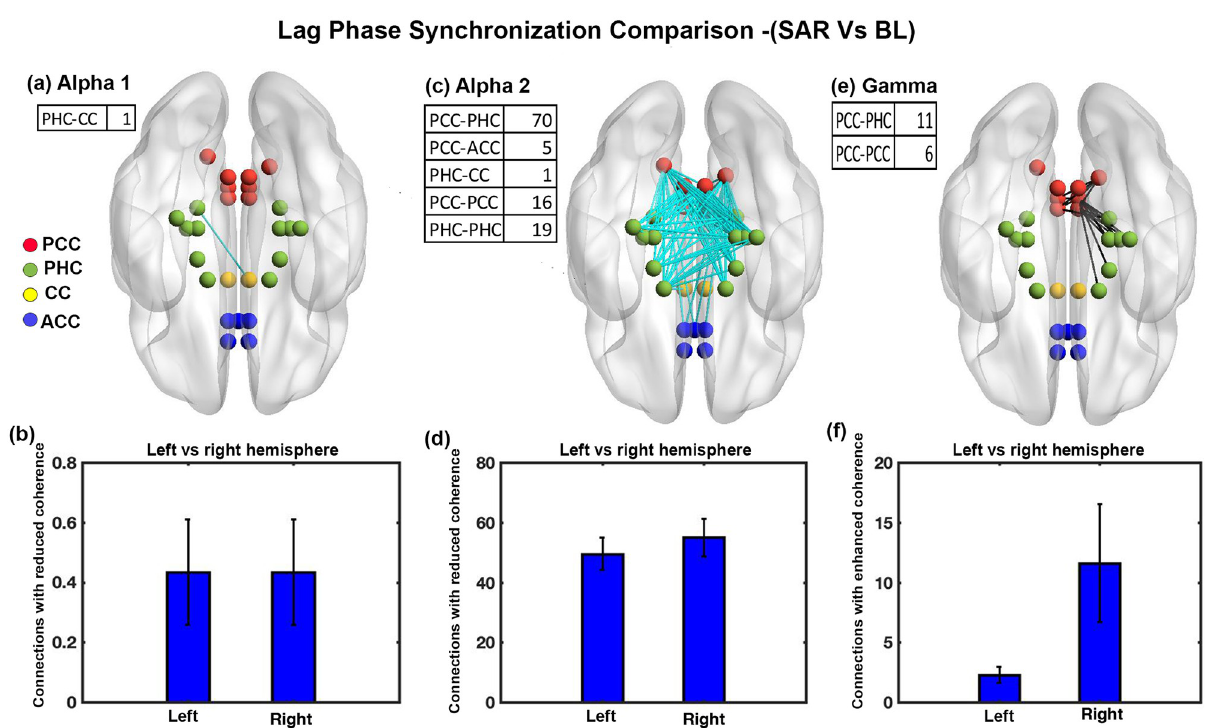
Fig 2. Phase coherence comparison between SAR condition and baseline resting state. (a) Brain’s connections (1) with a significant decrease in the lag phase synchronization value in alpha1 band, (b) Brain hemisphere lateralization with respect to inter-connections with reduced coherence in alpha1 band,(c) Brain’s connections (111) with a significant decrease in the lag phase synchronization value in alpha2 band. (d) Brain hemisphere lateralization with respect to inter-connections with reduced coherence in alpha2 band, (e) Brain’s connections (17) with a significant increase in the lag phase synchronization value in gamma band (f) Brain hemisphere lateralization with respect to inter-connections with increase coherence in gamma band (error bars = 1 SD).